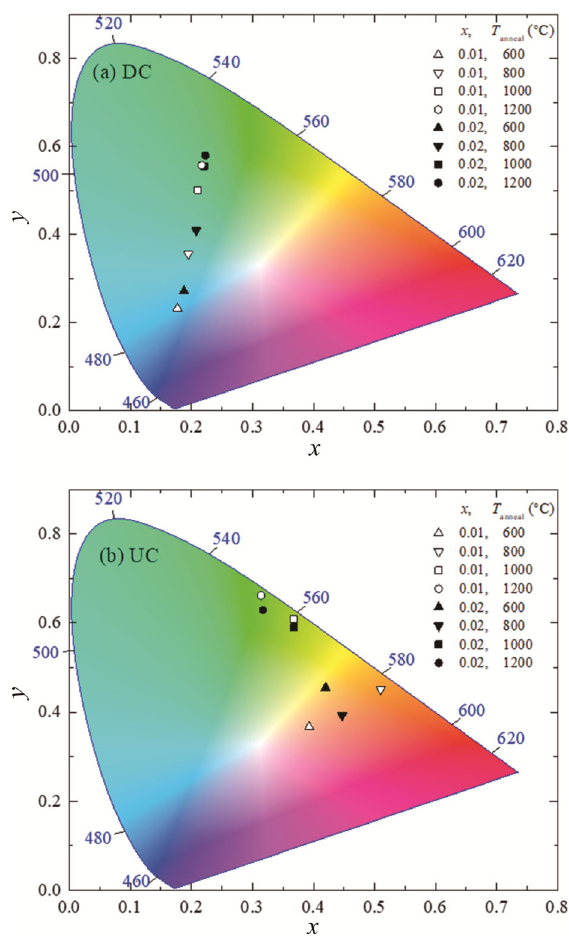
Fig. 11 CIE chromaticity diagram of SZO:Er,Yb NCs for (a) DS and (b)